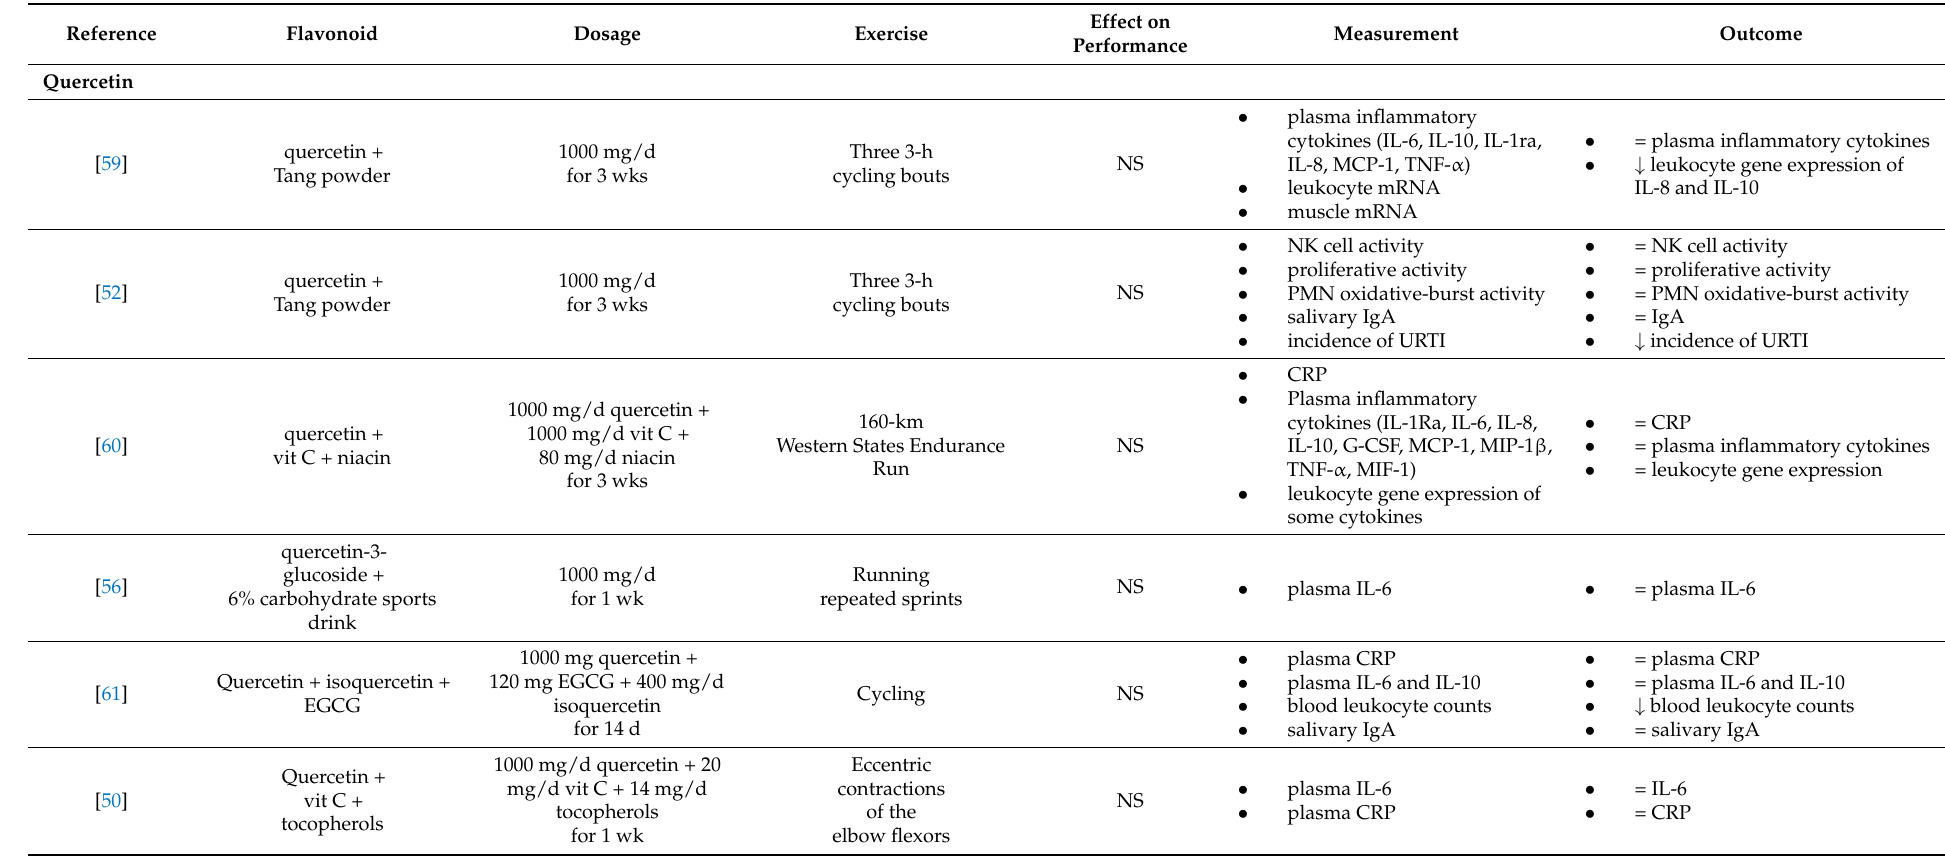
Table 3. Summary of the included studies assessing the association between flavonoid intake, exercise performance, and immune status biomarkers in humans.